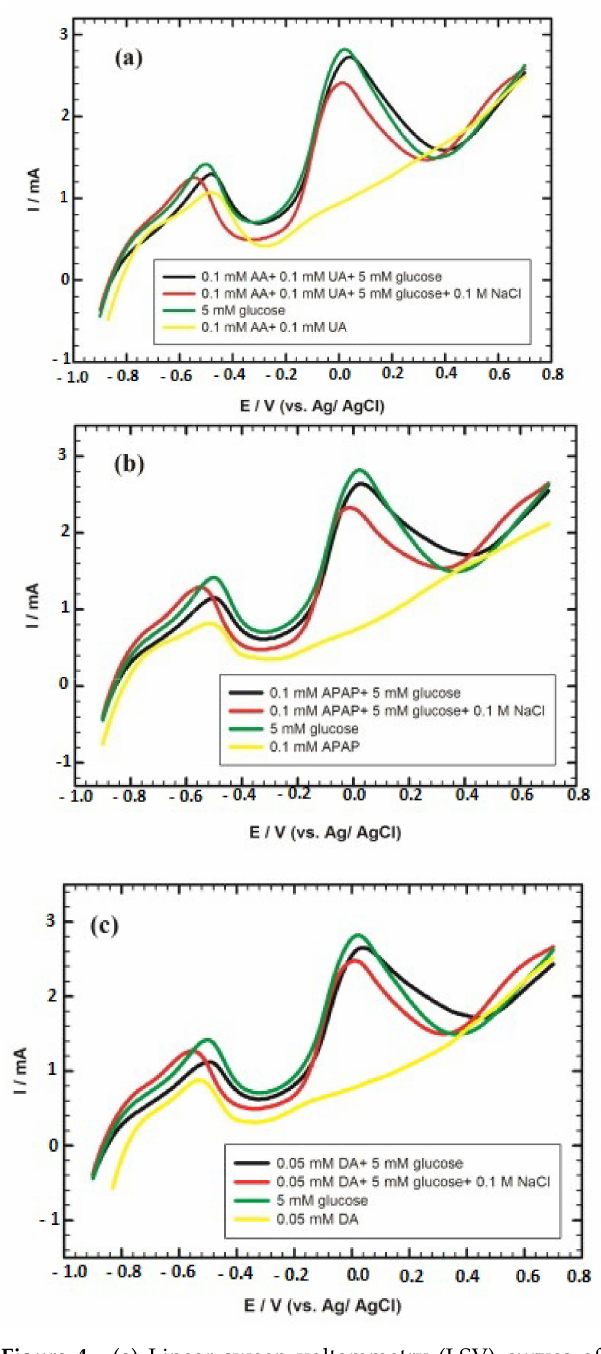
Figure 4. ( a ) Linear sweep voltammetry (LSV) curves of 5 mM glucose/0.1 M NaOH in the absence and the presence of 0.1 mM ascorbic acid (AA), 0.1 mM uric acid (UA) and 0.1 M NaCl at graphite/SrPdO 3 /AuNPs. ( b ) LSV curves of 5 mM/0.1 M NaOH in the absence and the presence of 0.1 mM N -acetyl-para-aminophenol or paracetamol (APAP) and 0.1 M NaCl at graphite/SrPdO 3 /AuNPs. ( c ) LSV curves of 5 mM glucose/0.1 M NaOH in the absence and the presence of 0.05 mM dopamine (DA) and 0.1 M NaCl at graphite/SrPdO 3 /AuNPs [43]. Reproduced with the permission from